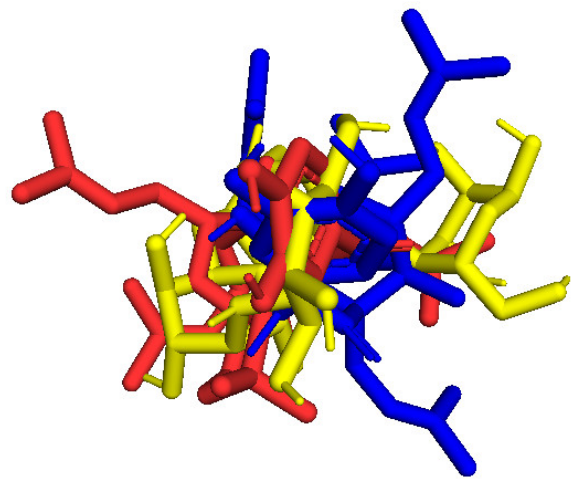
Figure 15. The active poses aligned to pose 170, acarbose, and RMSD calculated by PyMOL software.